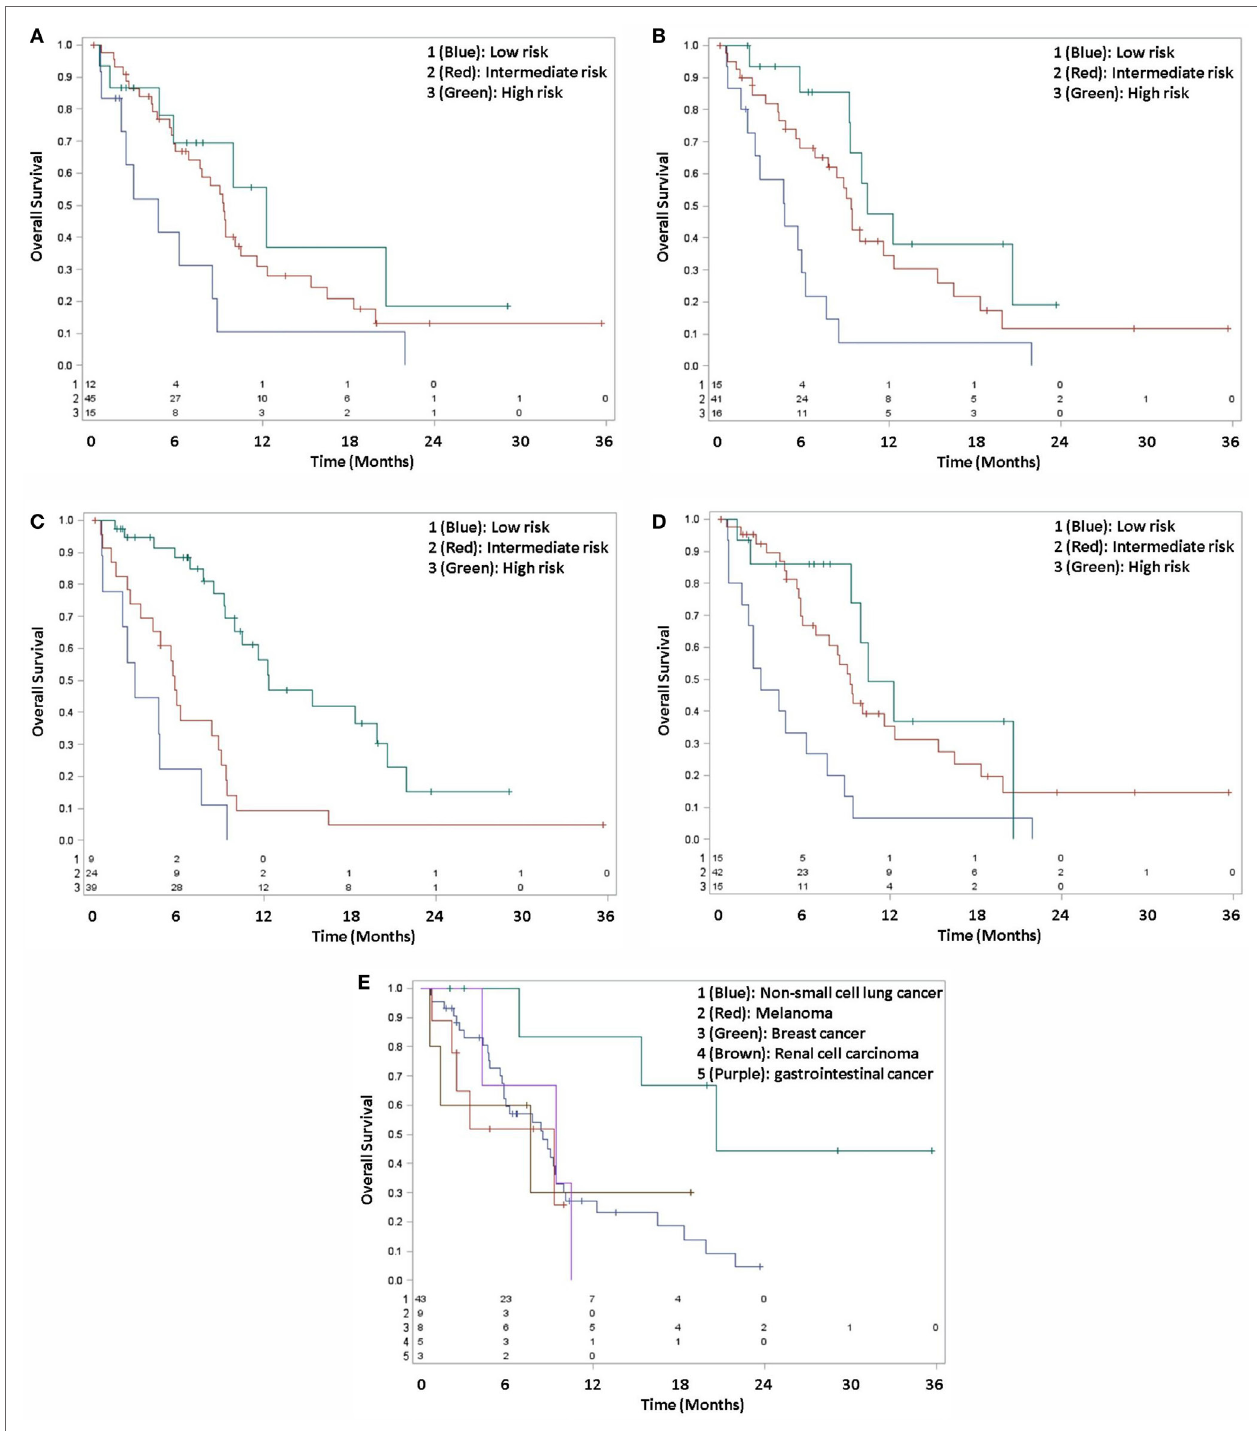
FigUre 1 | Kaplan–Meier survival curves, grouped by sir (a), rPa (B), BsBM (c), gPa (D), and DsgPa (e)